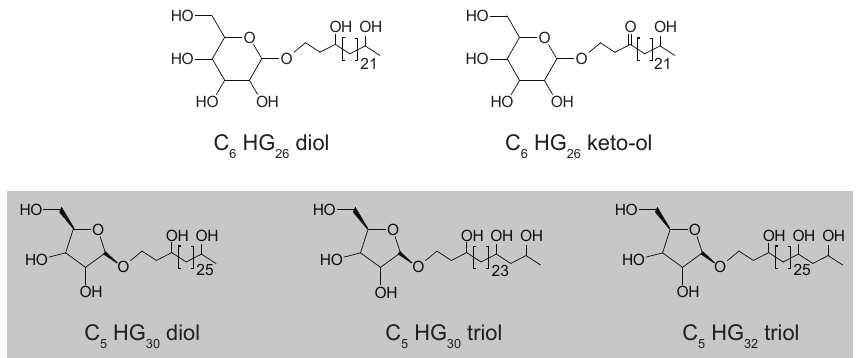
Figure 1. Structures of the heterocyst glycolipids detected in this study. C 6 glycolipids: 1-(O-hexose)-3,25-hexacosanediol (C 6 HG 26 diol), 1-(O-hexose)-3-keto-25-hexacosanol (C 6 HG 26 keto-ol). C 5 glycolipids: 1-(O-ribose)-3,29-triacontanediol (C 5 HG 30 diol), 1-(O-ribose)- 3,27,29-triacontanetriol (C 5 HG 30 triol), 1-(O-ribose)-3,29,32-dotriacontanetriol (C 5 HG 32 triol). Grey box indicates glycolipids associated with